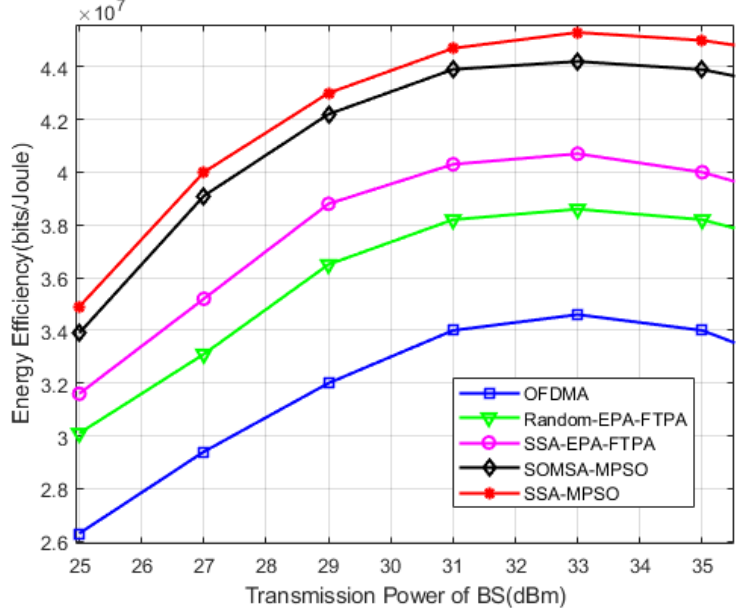
Figure 5. Energy efficiency versus maximum transmission power of BS.